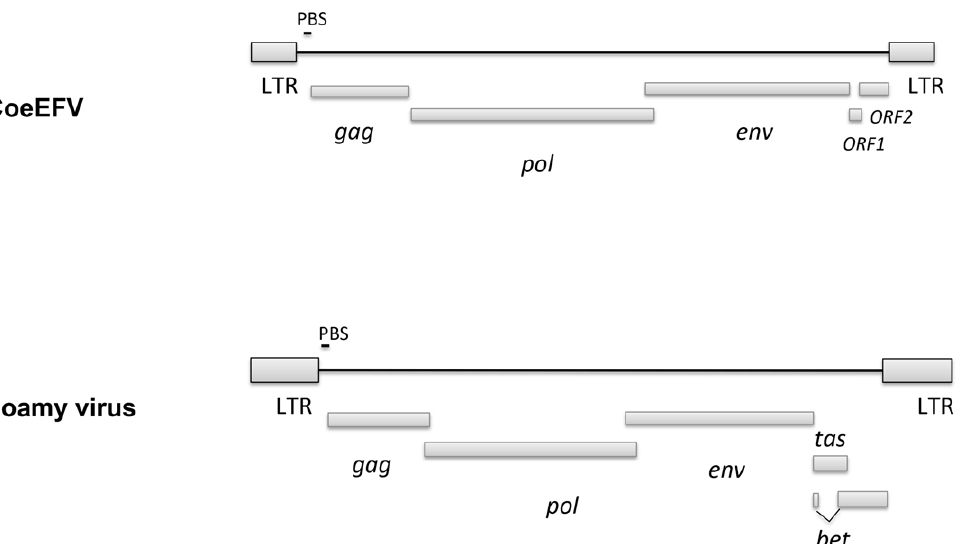
Figure 1. Comparison of the genome structures between CoeEFV and typical exogenous foamy virus. LTR, long-terminal repeat; PBS, primer-binding site.